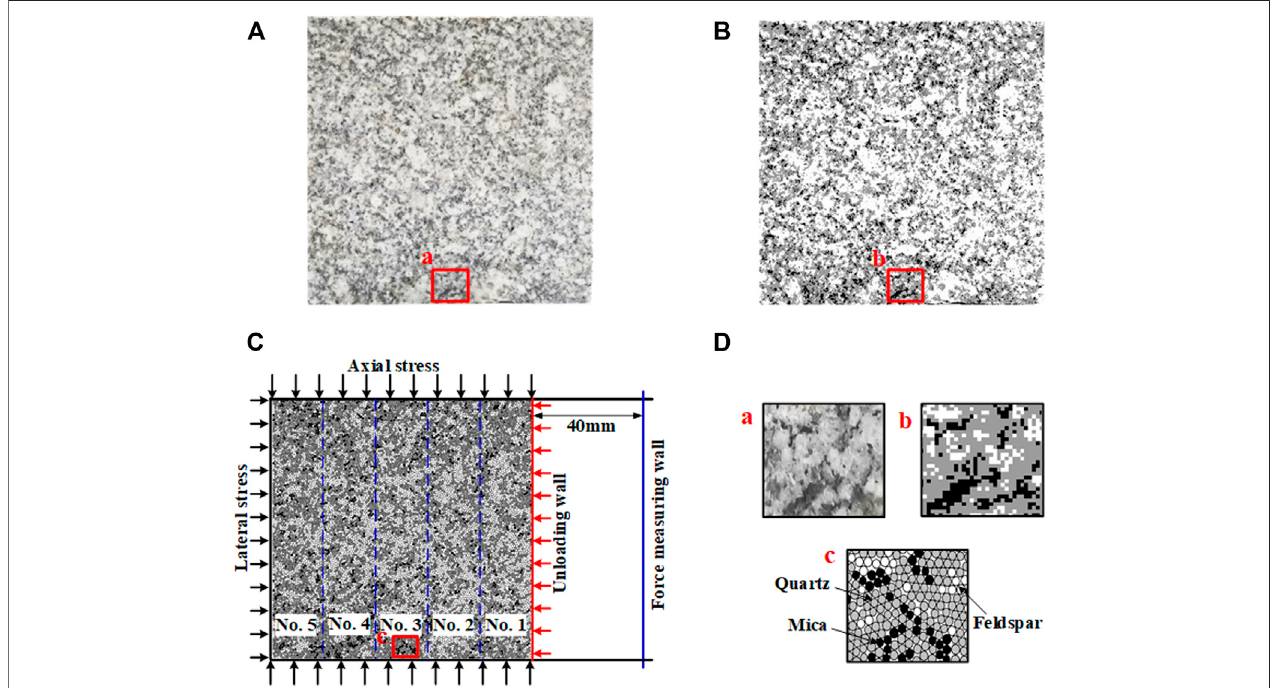
FIGURE 1 | Image of the granite. (A) True digital image; (B) characterization image; (C) layout of model grouping and ejection force monitoring; (D) local image comparison.